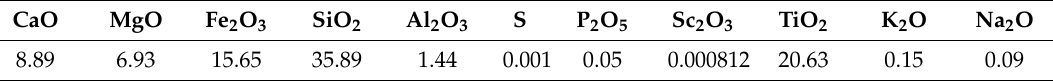
Table 6. Main chemical composition analysis results of scale-up acid leaching test (wt %).